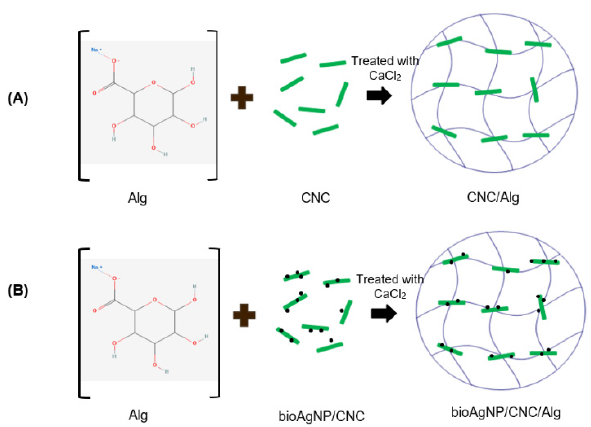
Figure 12. Schematic diagram of the formation of CNC/Alg ( A ) and bioAgNP/CNC/Alg ( B ). This hydrogel film was formed using a heating and stirring technique and was further crosslinked using Ca 2+ ions.